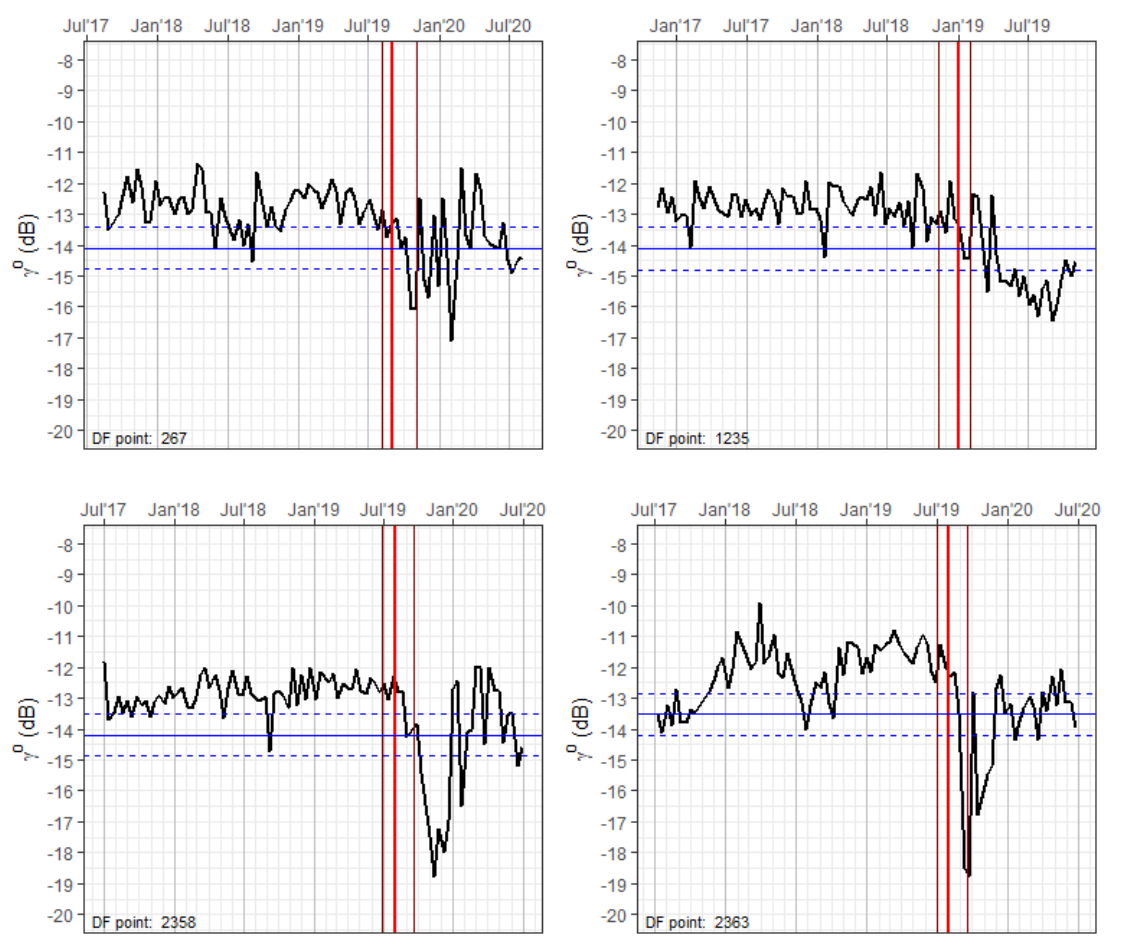
Figure 11. Speckle-filtered original VH time series of four deforested locations in the Amazon. The blue line represents the adaptive threshold automatically computed based on the regional relationship between backscattering means and minima. The dashed lines represent the 2 σ interval of the global threshold distribution. The red thin vertical lines represent the location reported before and after dates of deforestation. The red bold line represents the reported date of deforestation.